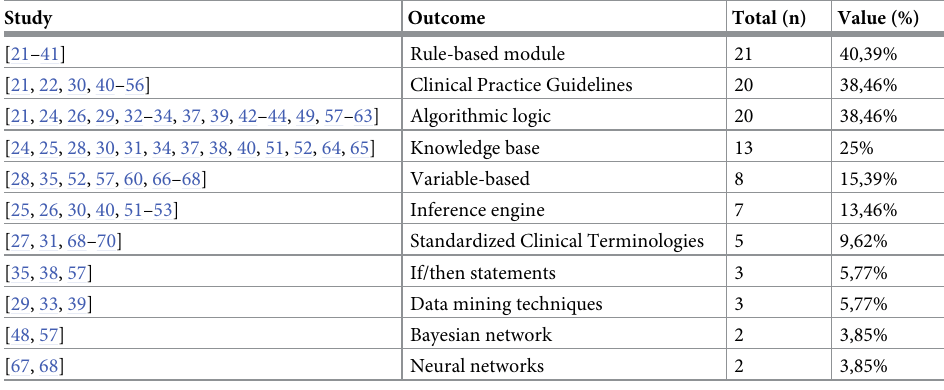
Table 3. Outcomes of knowledge representation and